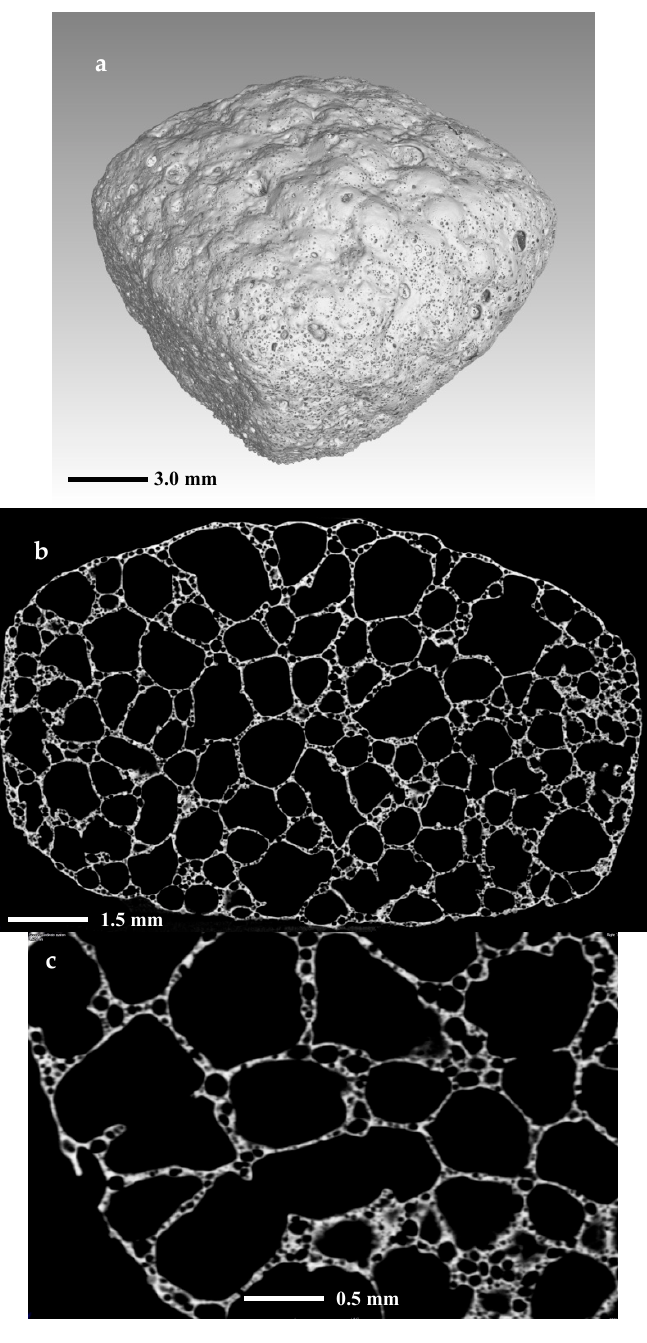
Figure 9. X-ray CT scan images of ( a ) 3D reconstruction of foam sample; ( b , c ) 2D intersection.